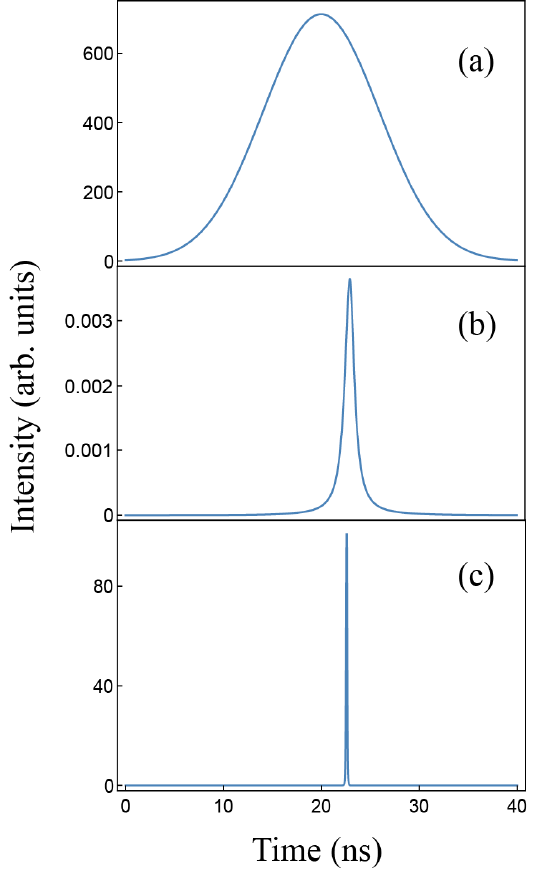
Figure 10. Temporal profile of a 14 ns pulsed pumping source ( a ); and calculated light intensity emitted in a situation of fluorescence emission ( b ); and laser emission at the threshold ( c ); using the data of Table 5 for PM597. Arbitrary units for curves ( b , c ) are the same.